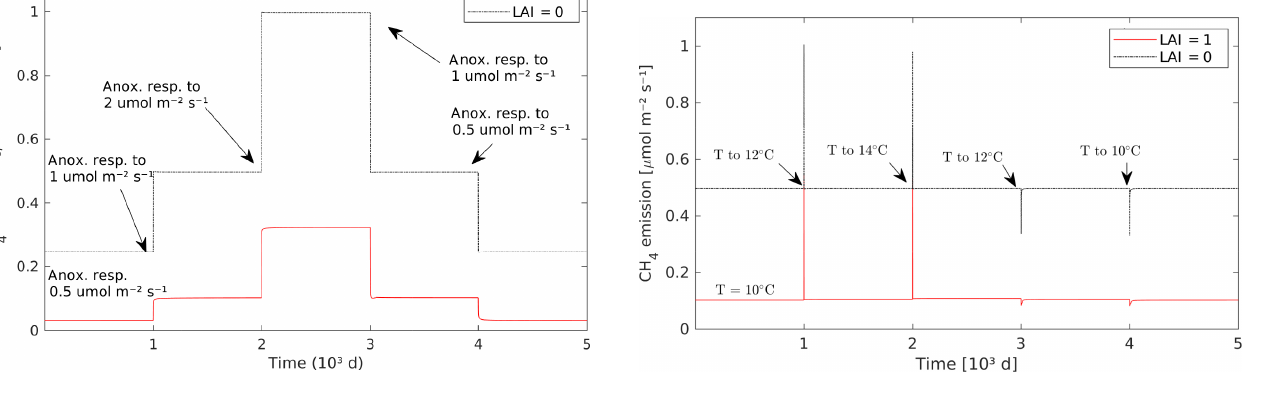
Figure 8. Response of CH 4 emission to changes in peat temperature in the transition tests Ttr_W0_L1 (red line) and Ttr_W0_L0 (black dashed line) (see Table 3). Black arrows indicate when the input